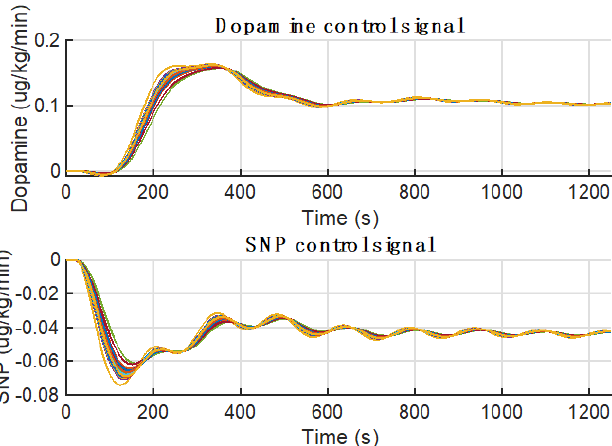
Figure 16. Propofol and Remifentanil control signals—simulation results with the proposed frac- tional-order switching function on all 24 patients.